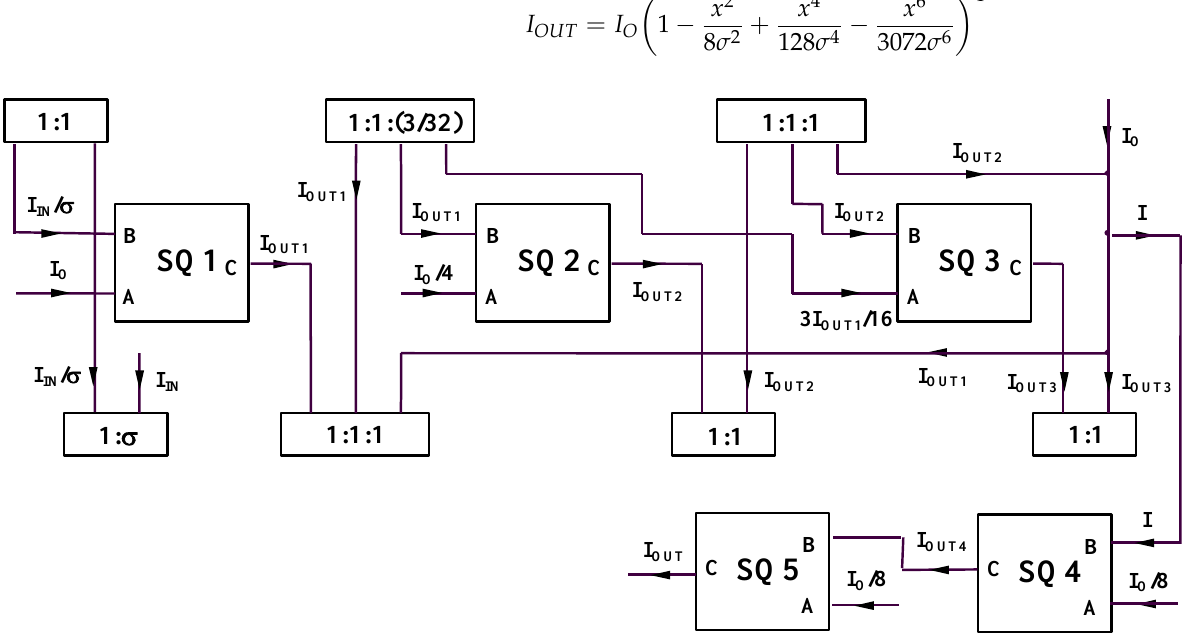
Figure 1. The block diagram of the improved accuracy Gaussian function generator.